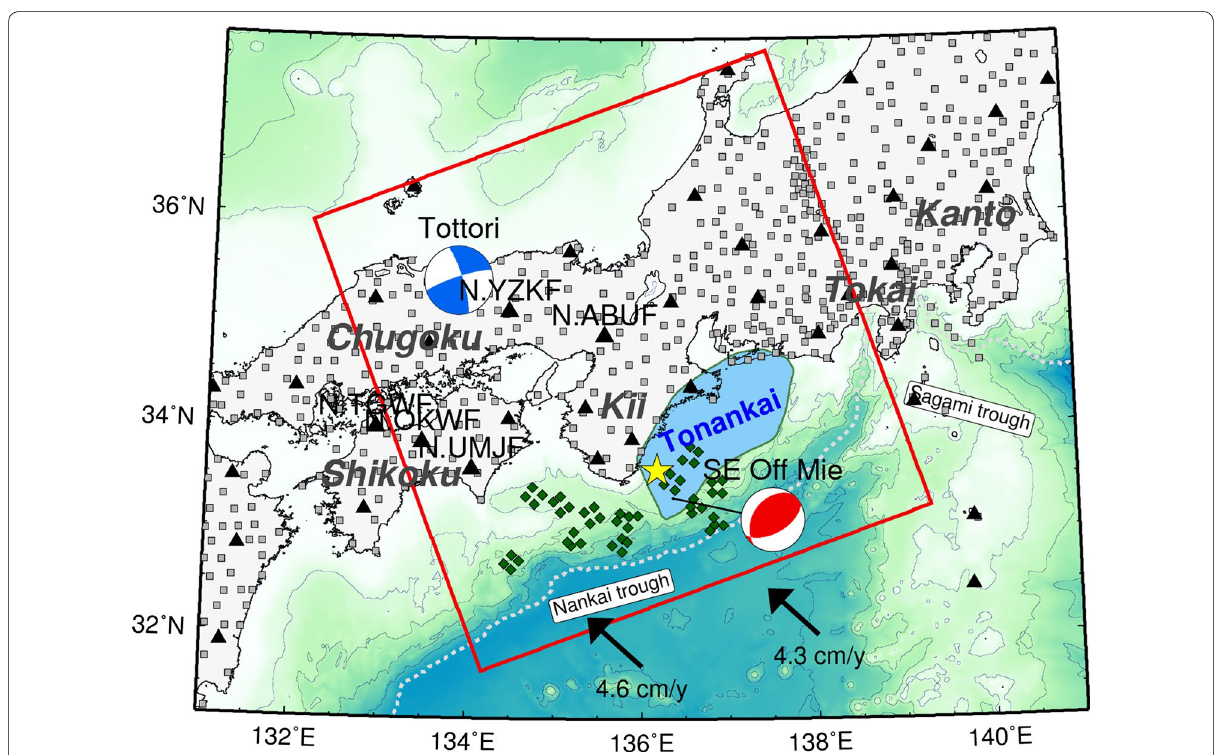
Fig. 1 Map and focal mechanisms of target earthquakes. Gray squares and black triangles are Hi-net and F-net stations, respectively. Green diamonds are station locations of DONET. The yellow star represents the epicenter of the 1944 Tonankai earthquake provided by the JMA catalog. The blue shaded area represents the expected source region of the Tonankai earthquake (Earthquake Research Committee, Long-term evaluation of earthquakes in the Nankai Trough, 2001, available at http://www.jishin.go.jp/main/chousa/01sep_nankai/index.htm). Arrows in the map indicate the convergence rate of the PHS referred from Seno et al. (1993). Focal mechanisms of the 2016 southeast offshore Mie ( M 6.5) and central Tottori ( M 6.6) earthquakes are from the F-net MT catalog. The red square represents the horizontal coverage of the model for the 3D FDM